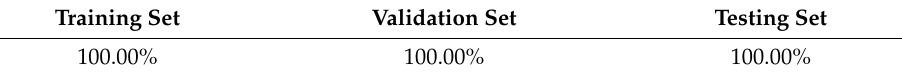
Table 4. Identification accuracy rate of each sample set.